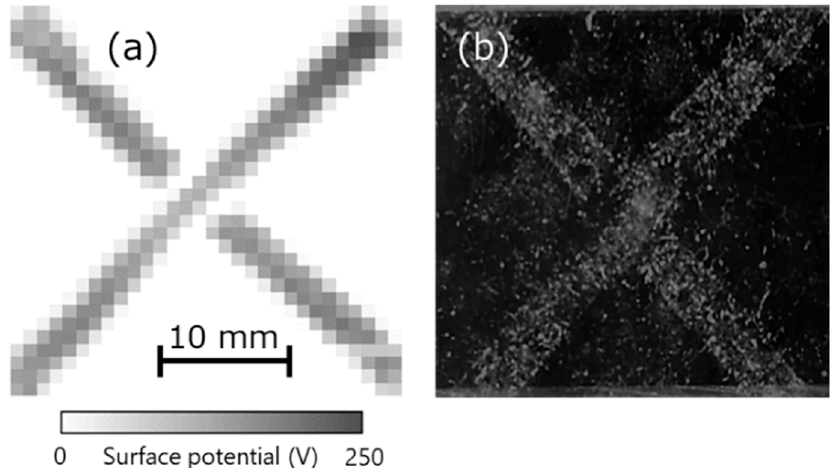
Figure 10. ( a ) Surface potential distribution of charged acrylic upon contacting vinyl chloride and ( b ) photograph after attaching dust.